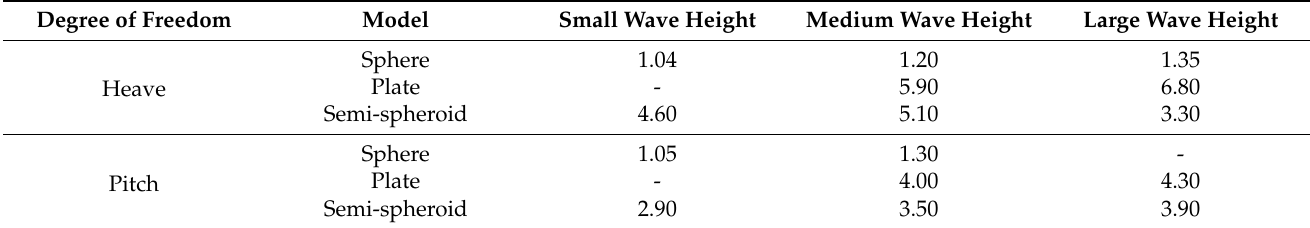
Table 10. Linear damping coefficients obtained from WAMIT code RAO results, ζ